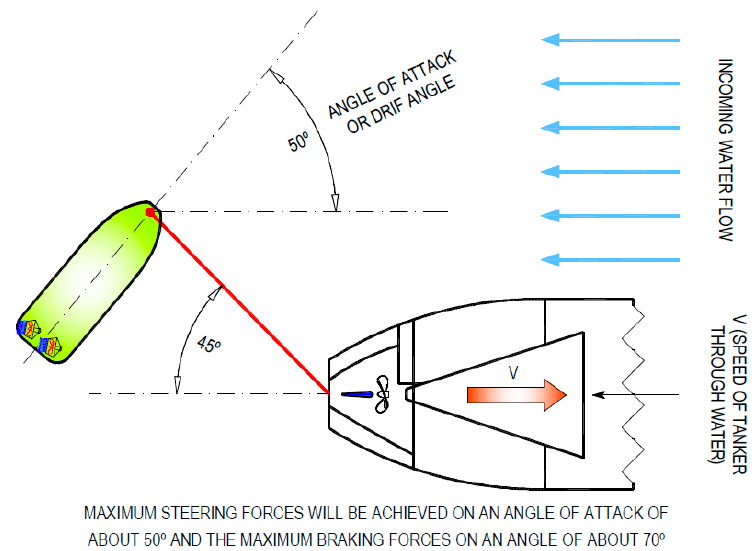
Figure 6. Pure indirect escort towing method by an ASD. Drawing: Authors.